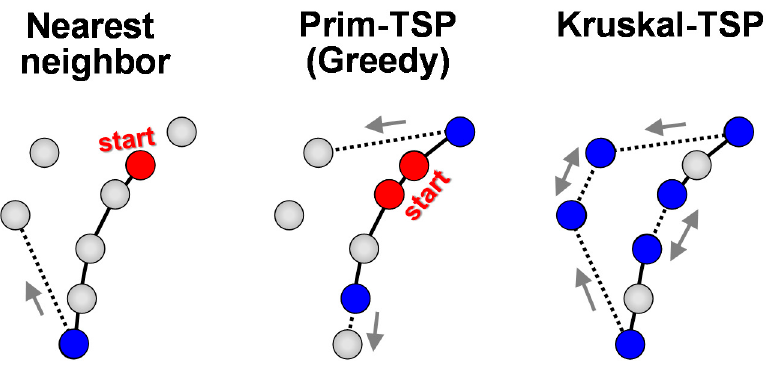
Figure 5. Differences between the Nearest Neighbor, Greedy, and Kruskal-TSP after the fourth merge. Nearest neighbor continues from the previously added point. Prim-TSP can continue from both ends. Kruskal has several sub-solutions that all can be extended further.